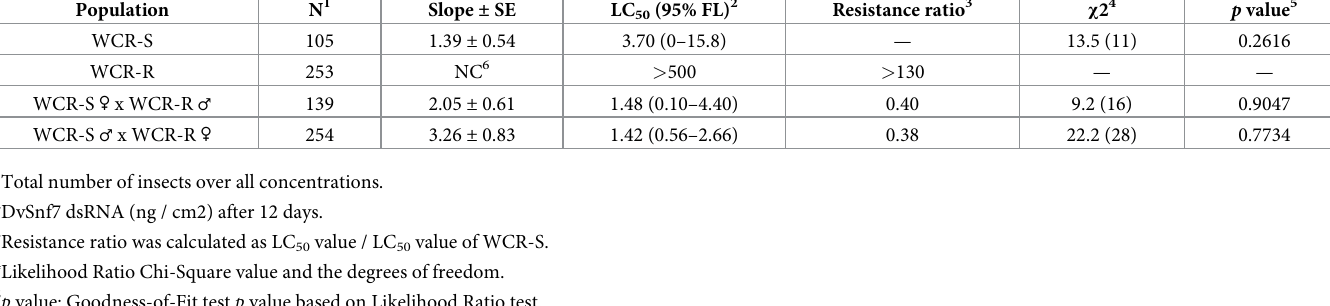
Table 1. Concentration response of WCR-R, WCR-S, and reciprocal crosses of each WCR population to DvSnf7 dsRNA overlaid on artificial diet. Population N